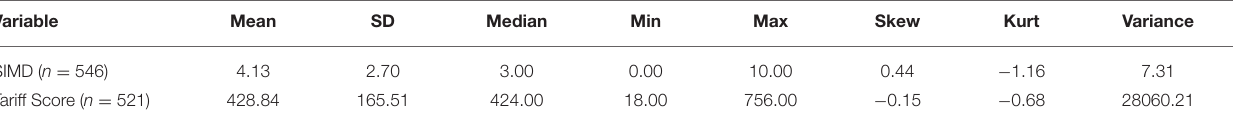
TABLE 1 | Descriptive statistics for mean Scottish Index of Multiple Deprivation and Tariff Score.